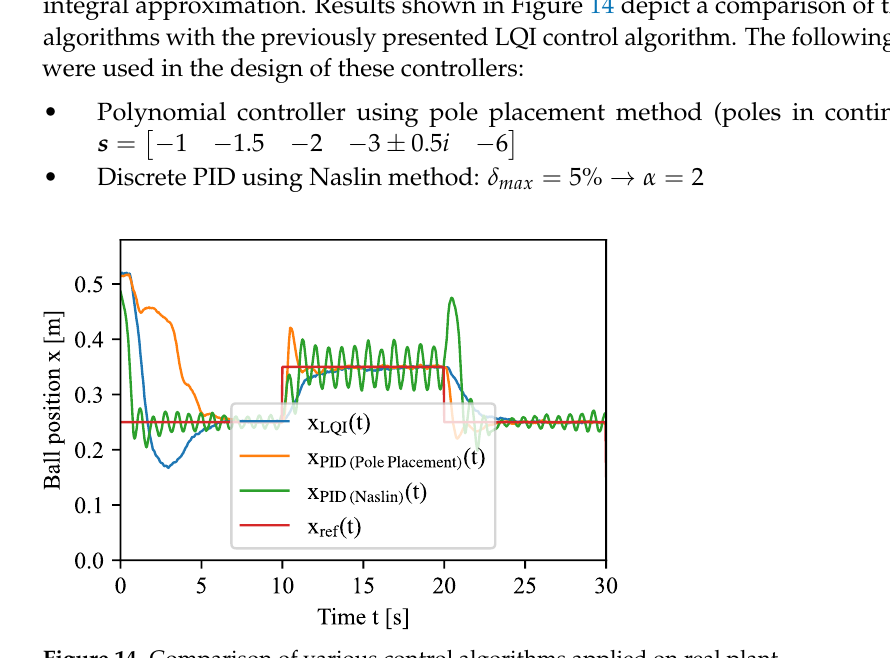
Figure 14. Comparison of various control algorithms applied on real plant.